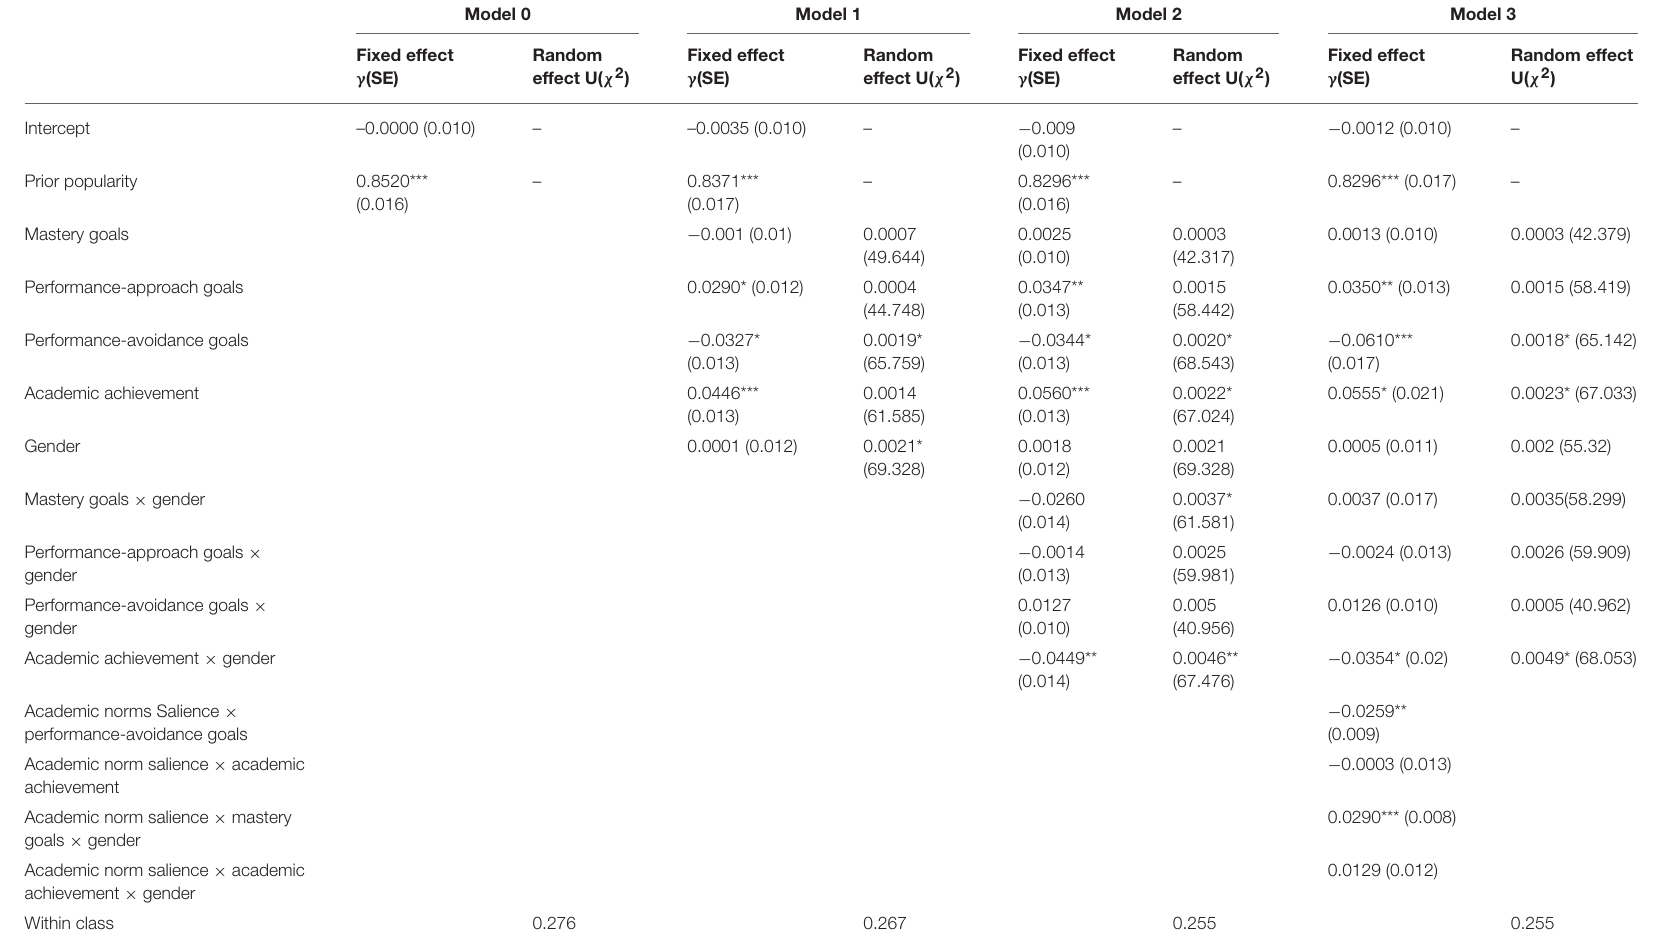
TABLE 3 | Random effect regression of perceived population on predictors and their interactions at Level 1, cross-level